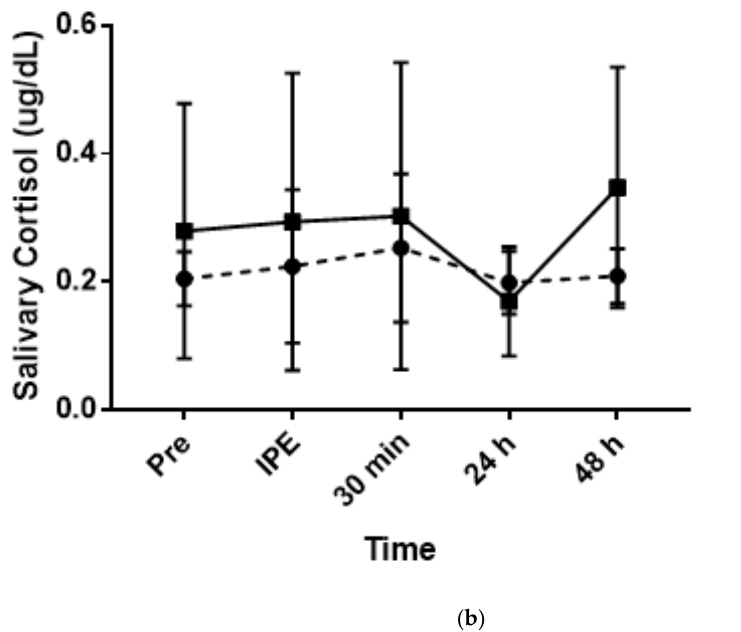
Figure 3. ( a ) Salivary CRP values immediately prior to and following the exercise protocol. Note: PTSD: post-traumatic stress disorder; TEC: trauma-exposed controls; CRP: c-reactive protein; IPE: immediately post exercise. ( b ) Salivary cortisol values immediately prior to and following the exercise protocol. Note: PTSD: post-traumatic stress disorder; TEC: trauma-exposed controls; IPE: immediately post exercise.